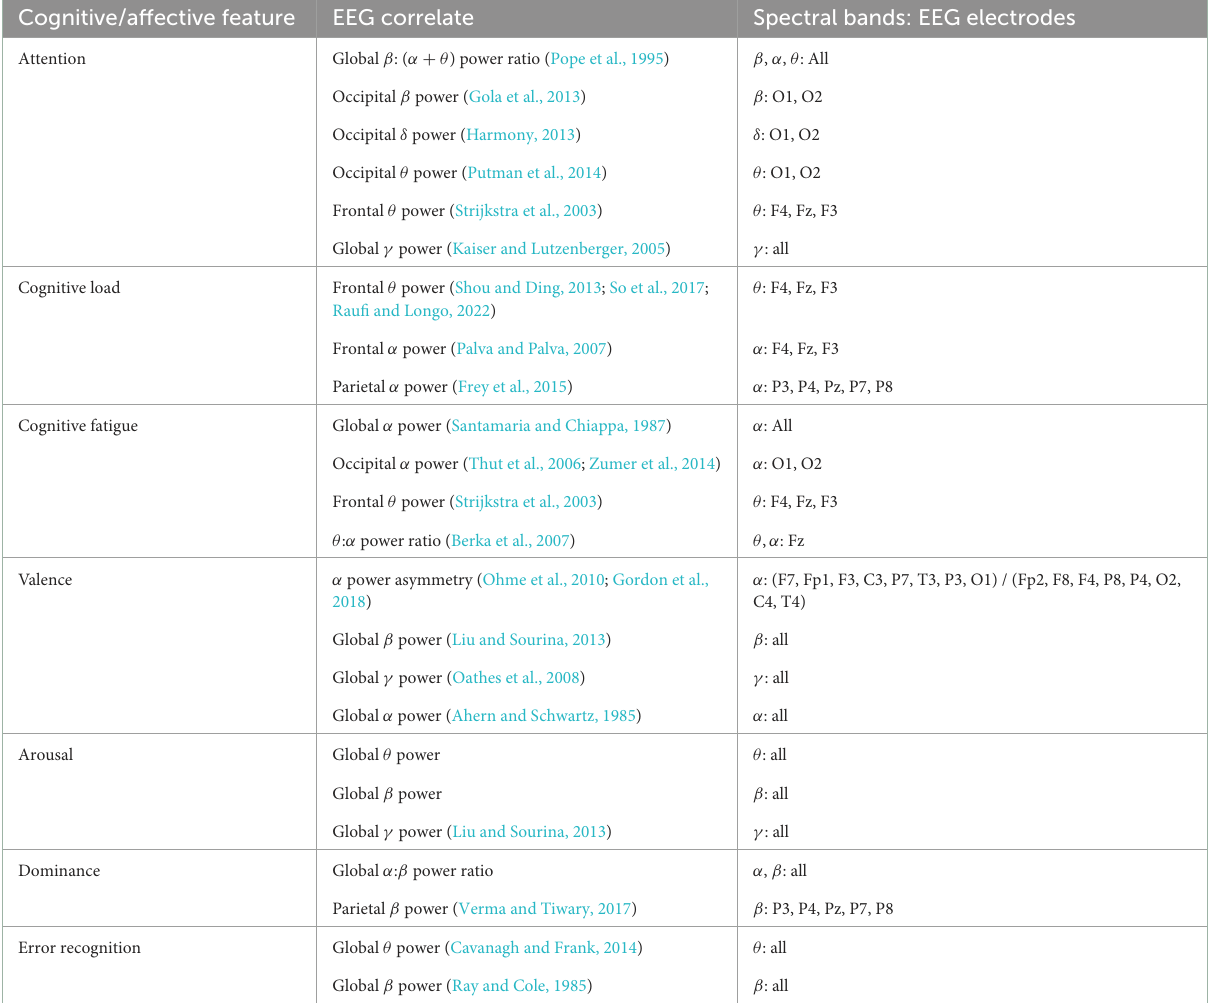
TABLE 1 EEG correlates of selected cognitive and affective features from previously published research. Cognitive/affective